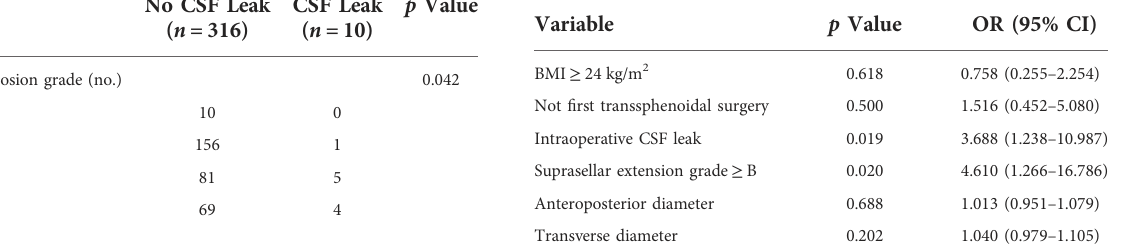
TABLE 4 Multivariate logistic regression for predictors of postoperative CSF